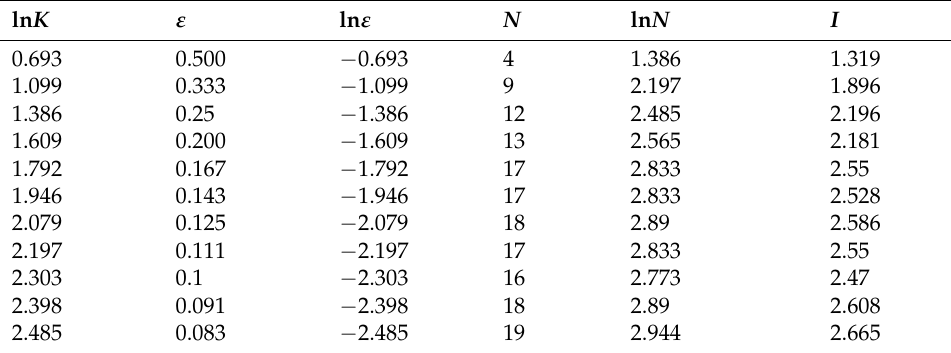
Table A7. Measurements for park system grid information